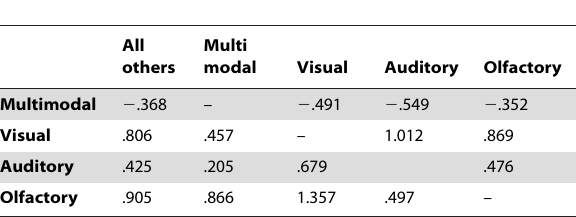
Table 2. Effect sizes (Cohen’s d ) for pairwise